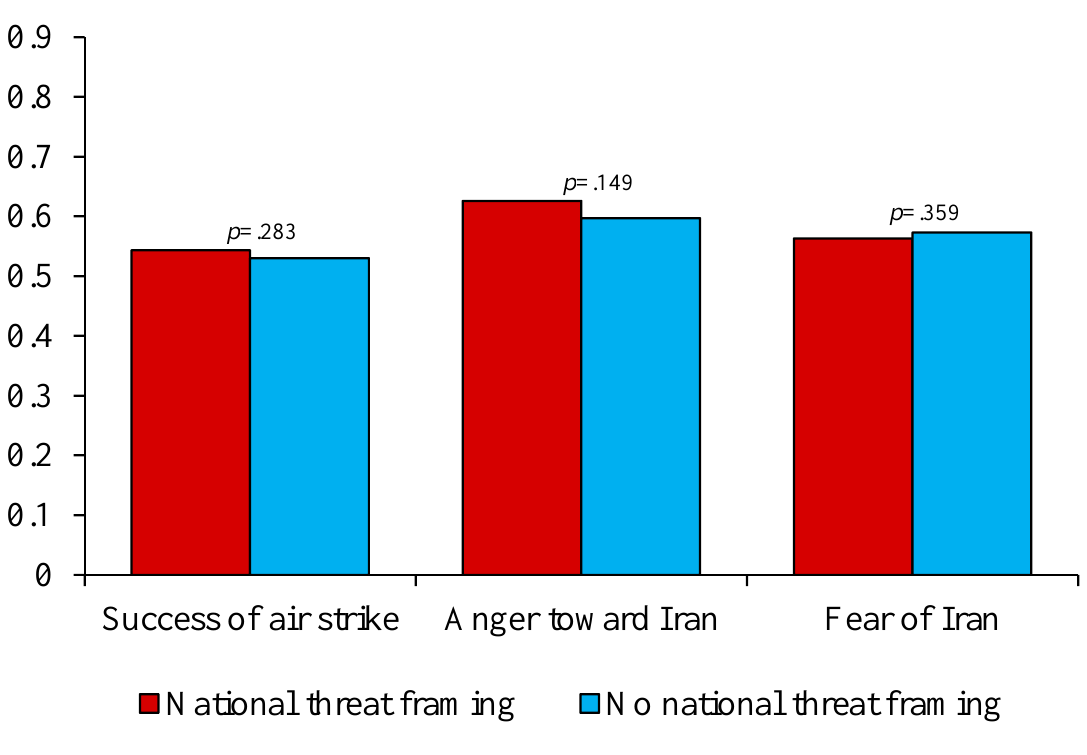
Figure 4: Effects of national threat framing on scales associated with competing explanations ( N = 558). p -Values are for the differences in means, based on independent samples t